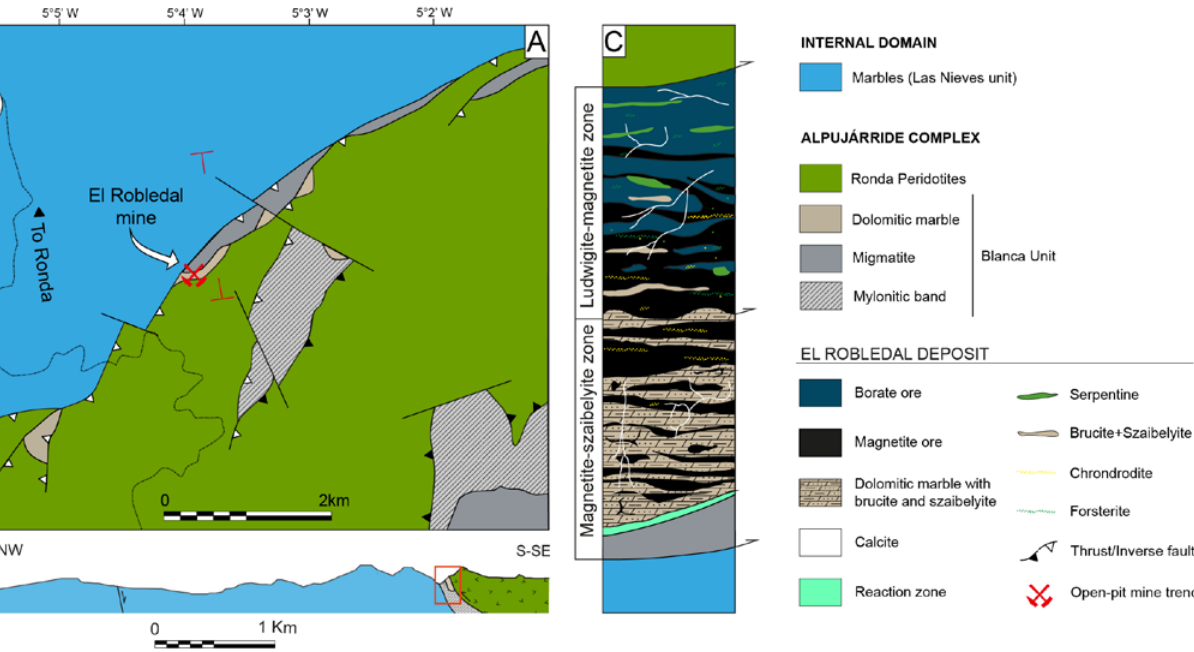
Figure 2. Geological sketch map of the El Robledal area: ( A ) simplified geological map of the northern contact of the Ronda Peridotites with the Las Nieves unit. Red lines mark the cross-section in B ( B ) geological cross-section of the northern contact of Ronda Peridotites and carbonates of the Las Nieves unit. Modified from Mazzoli and Algarra [51]. The red square highlights the location of the El Robledal deposit; ( C ) schematic column showing the structural disposition of the different zones of the El Robledal skarn. The column is rotated 90 degrees approximately with respect to the ore deposit distribution in the field, (which follows a lateral disposition) to ease the understanding of the deposit.